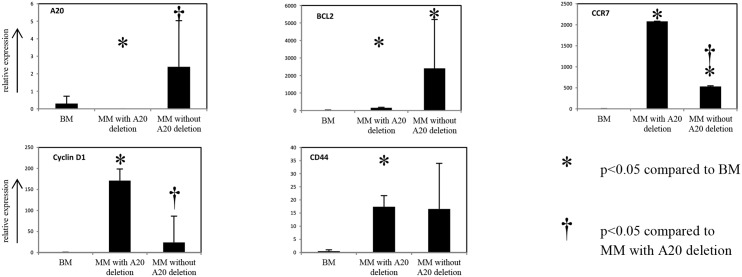
mRNA expression analysis of A20 and 7 NF-κB target genes (BCL2, Cyclin D1, CCR7, CD44, CXCR2, cFlip, IRF4) of MM cases with (n = 6) and without (n = 14) monoallelic A20 deletions and of non-neoplastic bone marrow biopsies (BM; n = 6).mRNA expression levels were calculated as relative expression in comparison with peripheral mononucleated cells serving as a calibrator. Each bar represents the mean values of expression levels ± standard deviation (SD). The comparison of the expression levels was performed by using the Mann-Whitney U test; all significant associations were corrected for multiple testing by applying a Bonferroni correction.